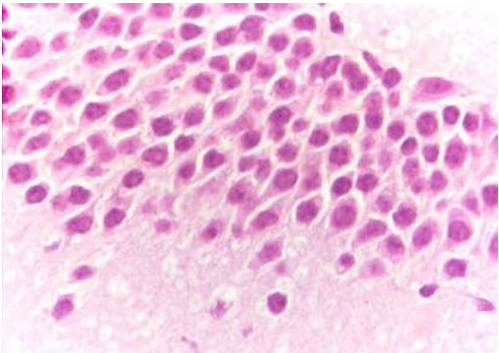
Figure 3: Histological section from the hippocampus of AIRmax mice used as negative controls.